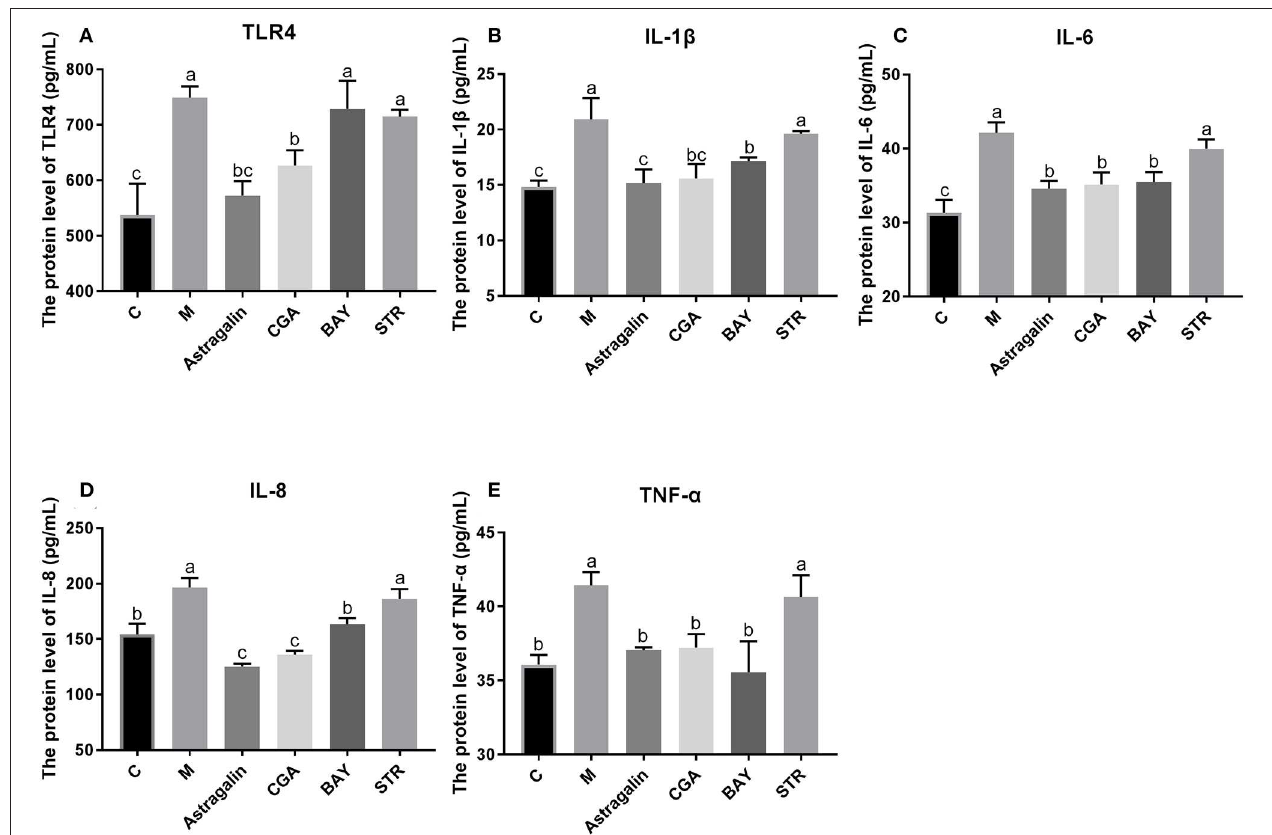
FIGURE 10 | The protein expression of genes in the TLR4/NF- κ B pathway. The SEECs were pretreated for 3h with various medicines (astragalin, CGA, BAY, and STR) and then exposed to E. coli for 3h, and the protein levels of TLR4, IL-1 β , IL-6, IL-8, and TNF- α were determined by ELISA. (A) The protein expression of TLR4. (B) The protein expression of IL-1 β . (C) The protein expression of IL-6. (D) The protein expression of IL-8. (E) The protein expression of TNF- α . Data are represented as the mean ± SD of three independent experiments with mixed SEECs from 15 sheep. Values with different lowercase letters were considered as statistically significant ( P <